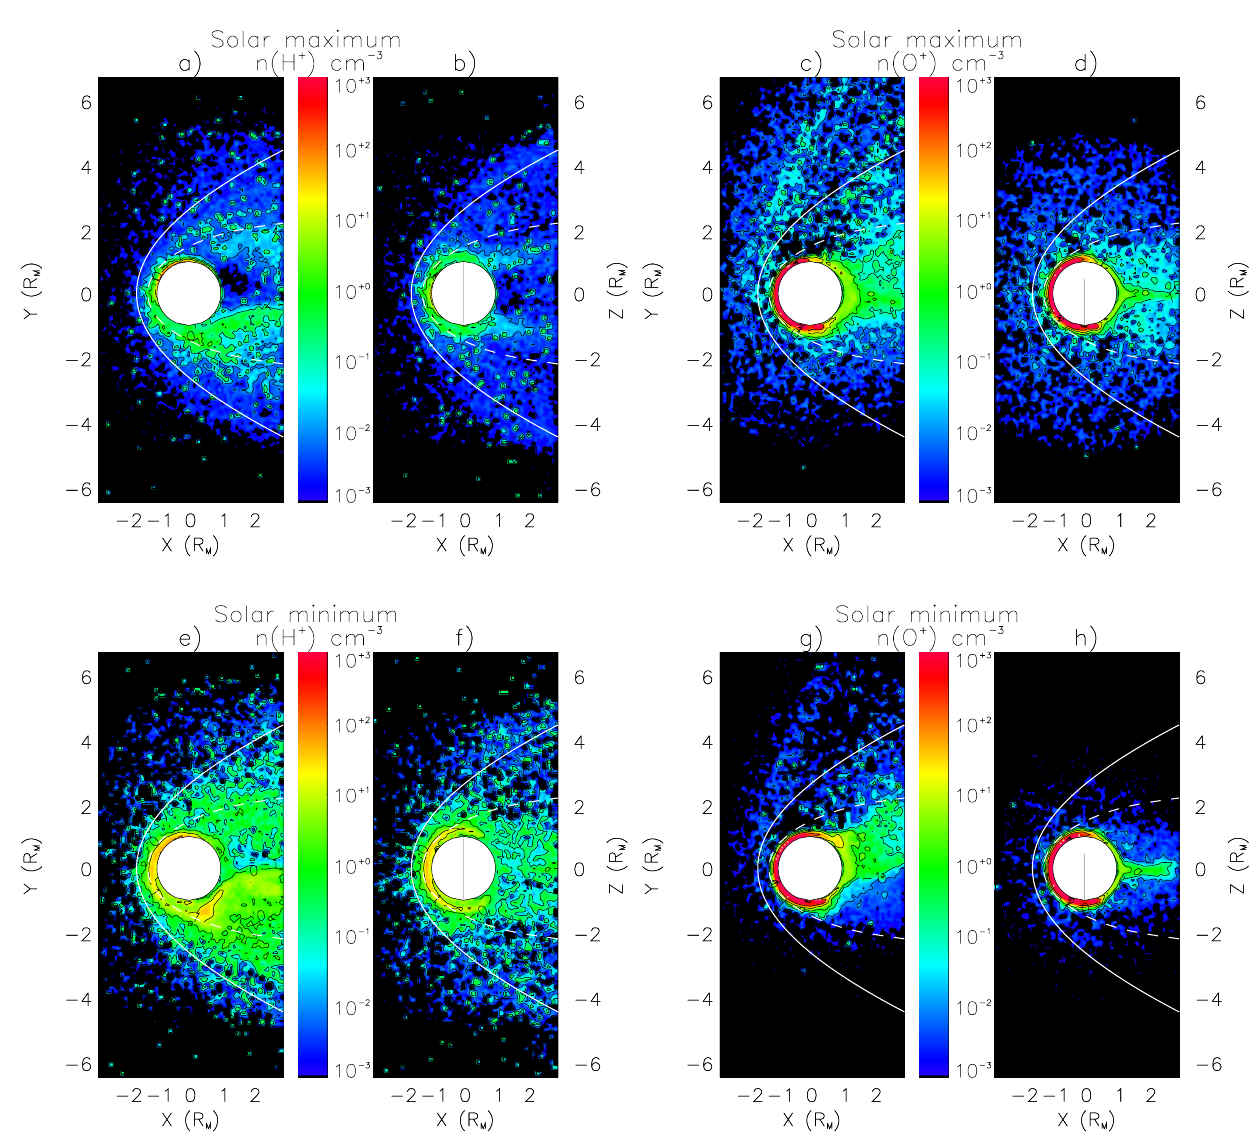
Fig. 5. Planetary ions. Density maps of planetary ions at solar maximum are presented on plates (a to d), and on plates (e to f) at solar minimum. Plates (a), (b), (e) , and (f) , refer to planetary protons while oxygen ions are displayed on plates (c, d, g) , and (h) . Plates (a), (c), (e), and (g) present density maps in the XY plane containing the convection electric field of the solar wind, whereas plates (b), (d), (f), and (h) display density maps in the XZ plane containing the IMF. Solid and dashed white curves are the fits of MGS observations for the BS and the MPB made by Vignes et al.